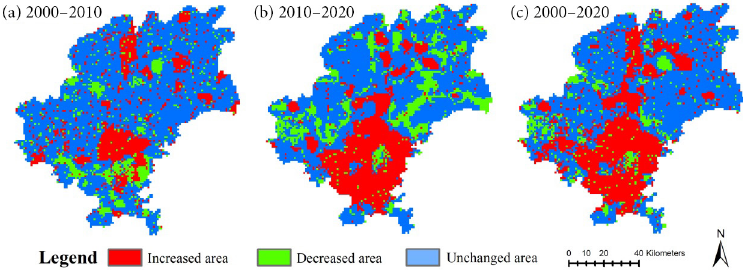
Figure 9. Spatial pattern of the human activity intensity change in